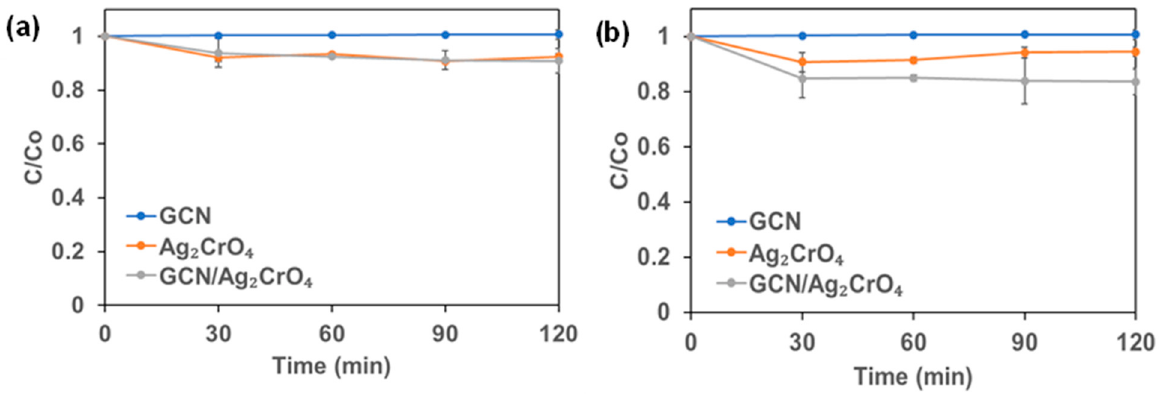
Figure 1. The dark experiment of Killex R : ( a ) 2,4-D and ( b ) Mecoprop-P.